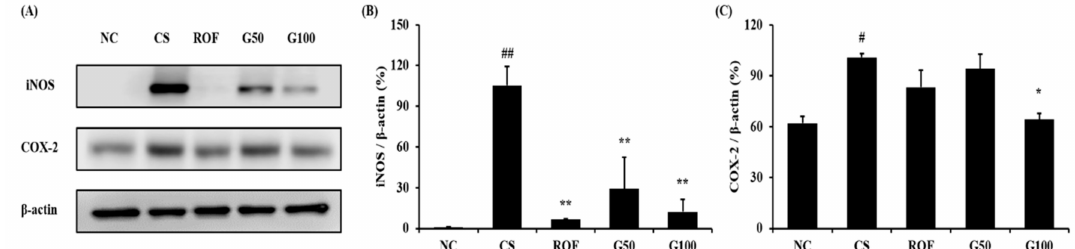
Figure 5. GGWE reduced the expression of iNOS and COX-2 in lung tissue. ( A ) Expression of iNOS and COX-2, ( B ) quantitative analysis for iNOS expression, ( C ) quantitative analysis for COX-2 expression. NC, non-treated mice; CS, CS and LPS exposure mice; ROF, roflumilast 10 mg/kg and CS and LPS exposure mice; G50, GGWE 50 mg/kg and CS and LPS exposure mice; G100, GGWE 100 mg/kg and CS and LPS exposure mice. The values shown are the mean ± SD. ## p < 0.01 vs. NC; # p < 0.05 vs. NC; ** p < 0.01 vs. CS; * p < 0.05 vs. CS.